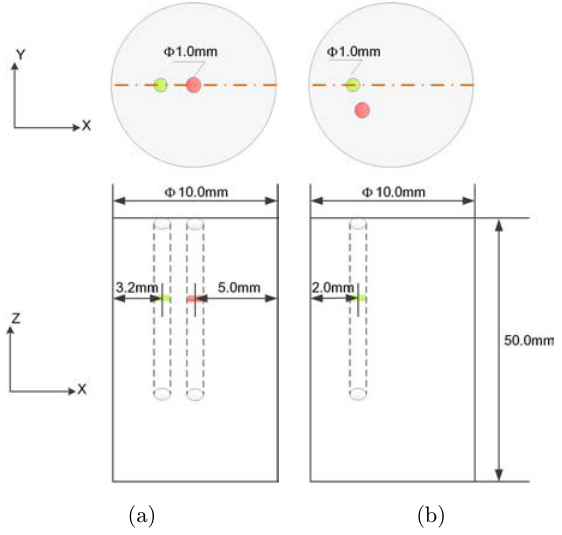
Fig. 6. Illustration of the phantom experimental setup. (a) The cross-section of the °uorophores in the ¯rst phantom and vertical section along the brown dashed dotted line. (b) The cross-section of the °uorophores in the second phantom and vertical section along the brown dashed dotted line. The two phantoms are cylindrical glass tubes (out diameter 10.0 mm) containing 1 % Intralipid. Capillary quartz tube (outer diameter (cid:1) 1 : 0 mm) ¯lled with (cid:1) 1 (cid:6) L red QDs solution (the pink circular spot) and the capillary quartz tube ¯lled with (cid:1) 1 (cid:6) L green QDs solution (the green circular spot) were positioned at di®erent depth within the di®usive medium.